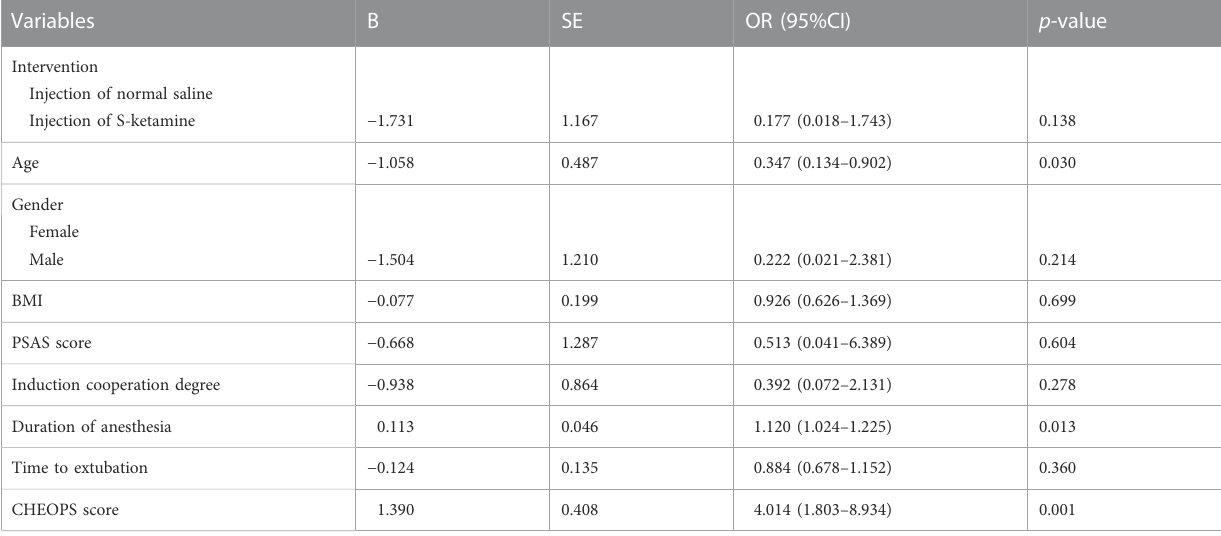
TABLE 5 Binary logistic regression of clinical factors that are potentially associated with ED (de fi ned as an Aono scale score of ≥ 3). Logistic regression analysis suggested that age, duration of anesthesia, and pain scores were independent predictors of ED.